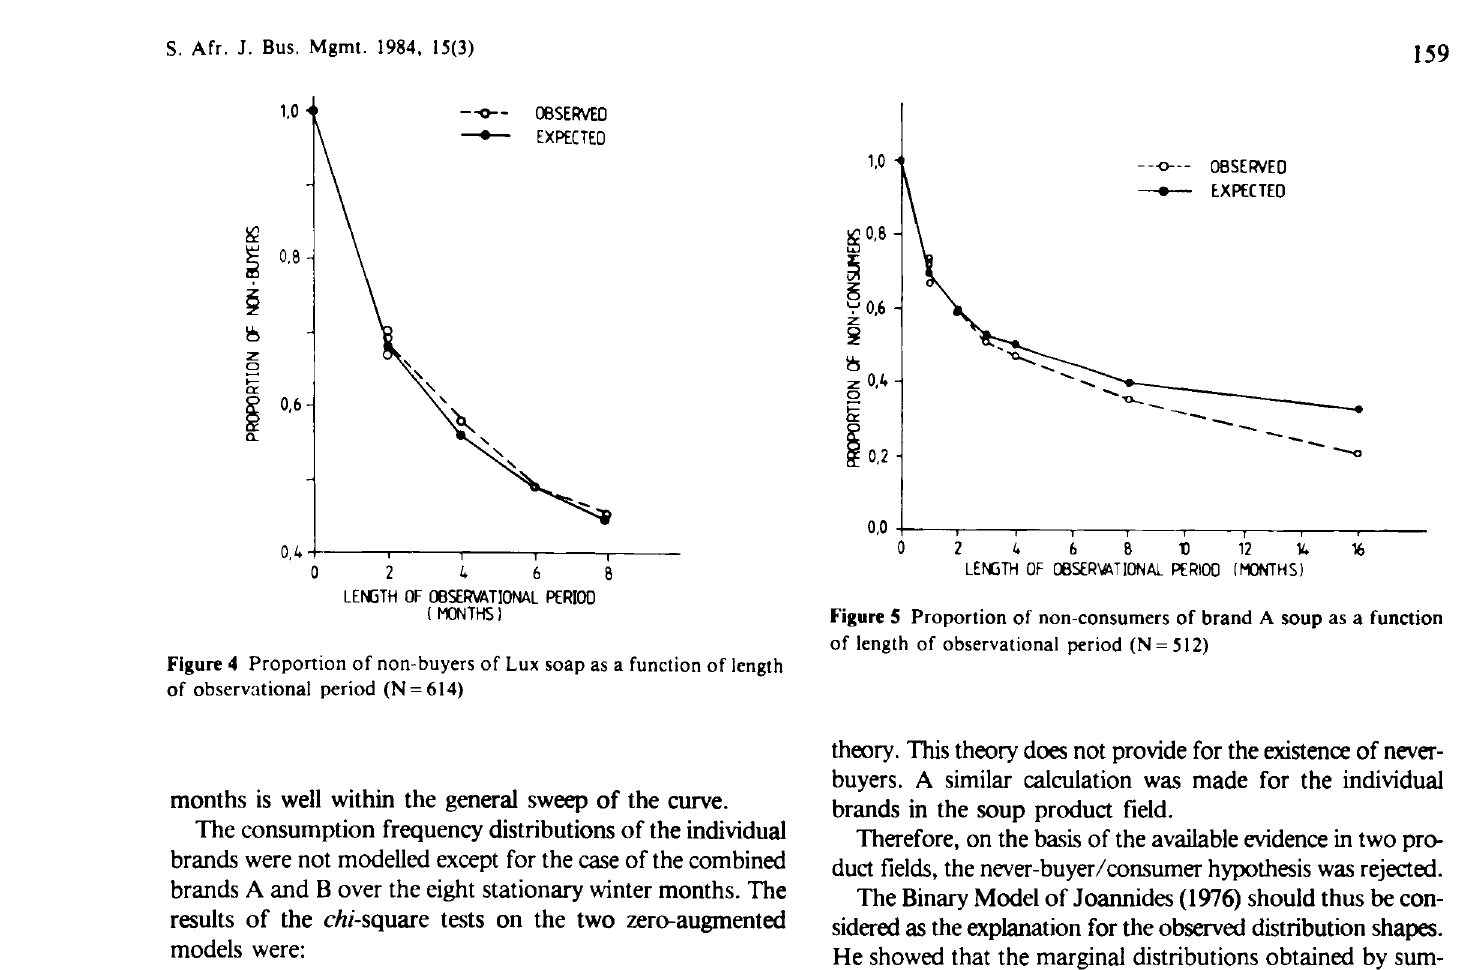
Figure 5 Proportion of non-consumers of brand A soup as a function of length of observational period (N = S